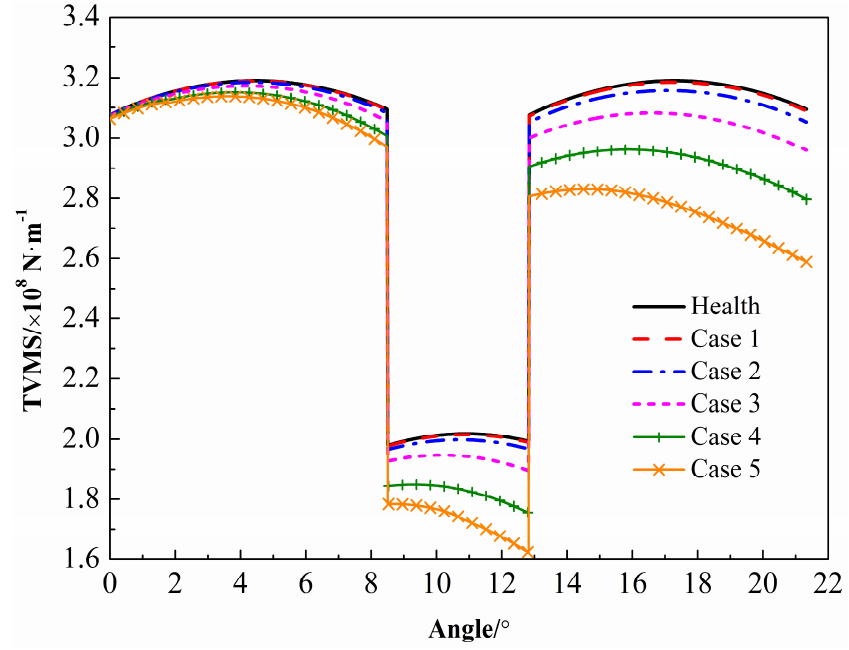
Figure 15. TVMS of the sun–planet pair in a single tooth meshing period. A planetary gear system contains N sun–planet pairs and N ring–planet pairs meshing simultaneously. Thus, 2 N mesh stiffness should be calculated for the following dynamic analysis. N sun–planet pairs have same mesh stiffness, but their phases might be different. Parker and Lin [52] investigated the mesh phase relationships of planetary gear systems and presented an efficient method to determine the phase relationships of the sun–planet pairs and ring–planet pairs. According to their method, the mesh phase of the planetary gear set in this study is listed in Table 3. β si ( i = 1, 2, . . . , N ) represents the relative phases between the i th sun–planet pair and the first sun–planet pair, while β ri ( i = 1, 2, . . . , N ) represents the relative phases between the i th ring–planet pair and the first ring–planet pair. β rs represents the relative phases between the i th ring–planet pair and the i th sun–planet pair. After obtaining these relative phases, the mesh stiffness of all sun–planet pairs and ring–planet pairs can then be obtained, and the corresponding results of case 5 are plotted in Figure 16. As all ring–planet pairs are healthy and the relative phases β ri are zero, the mesh stiffnesses of all ring–planet pairs are the same, represented by k rp in the fifth subgraph of Figure 16. T m represents the mesh period of the planetary gear system. The horizontal axis t / T m denotes the number of mesh period. As the tooth crack occurs on the sun gear, all sun–planet pairs are affected when the cracked tooth engages. The time interval between two adjacent sun–planet pair is 7 T m , and the time interval between the sun–planet pair and the ring–planet pair is β r s T m . Table 3. Relative phases of the planetary gear